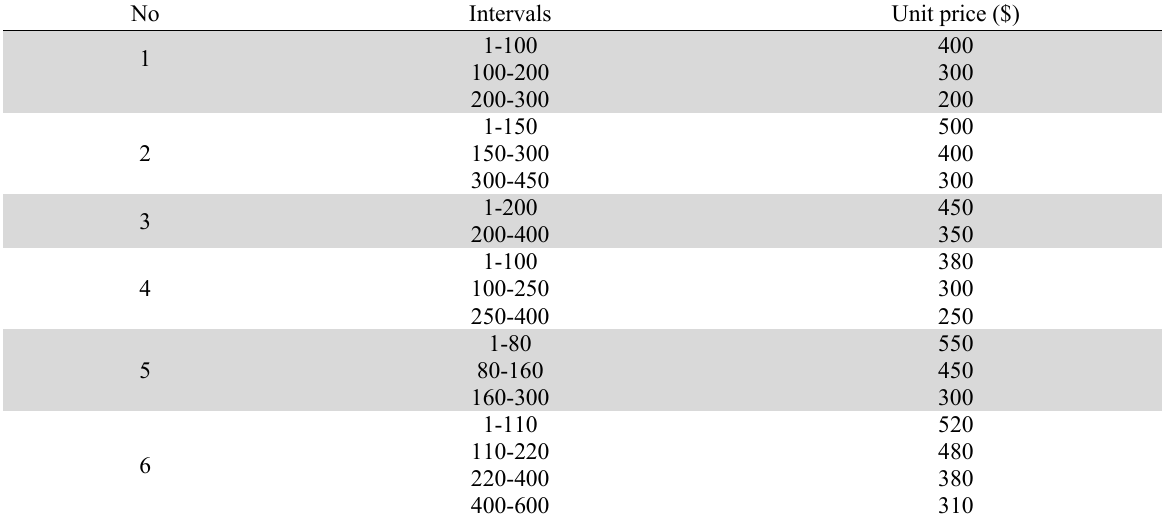
Discount intervals of